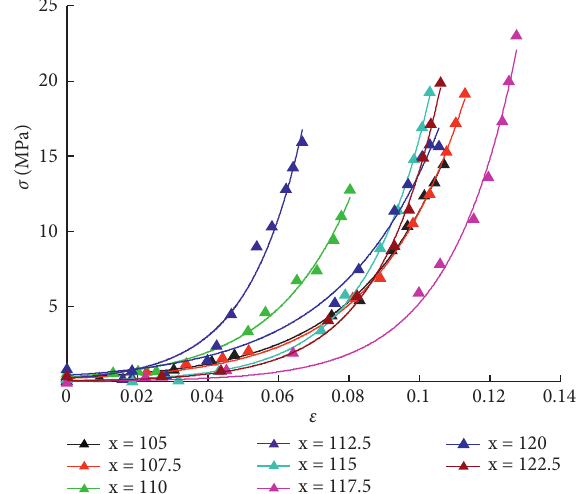
Figure 12: Stress-strain relationship of the gob at different positions.